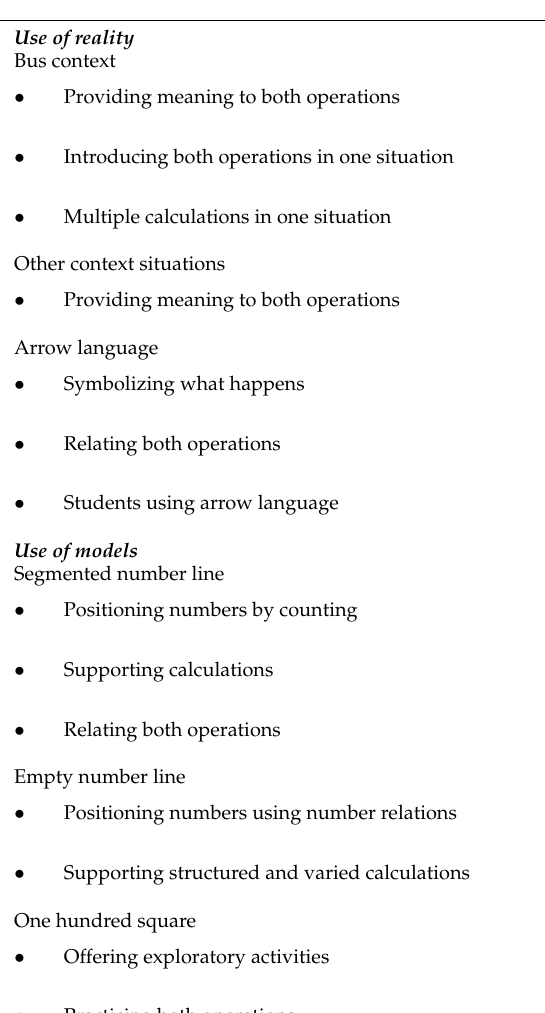
Table 4. RME learning facilitators and their intended use for early addition and subtraction in Wiskobas (W), Proeve (P), TAL (T), and RME-oriented textbooks per time period. W P RME Learning Facilitators and Intended Use for Early Addition and Subtraction 1